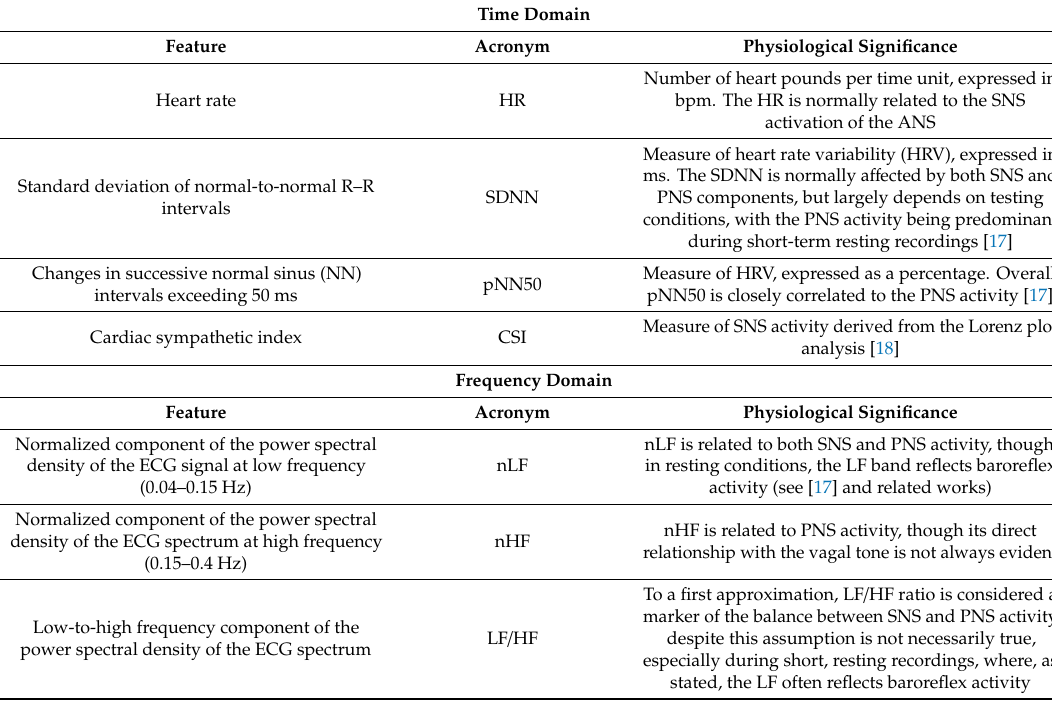
Table 1. Time- and frequency-domain features extracted from the ECG